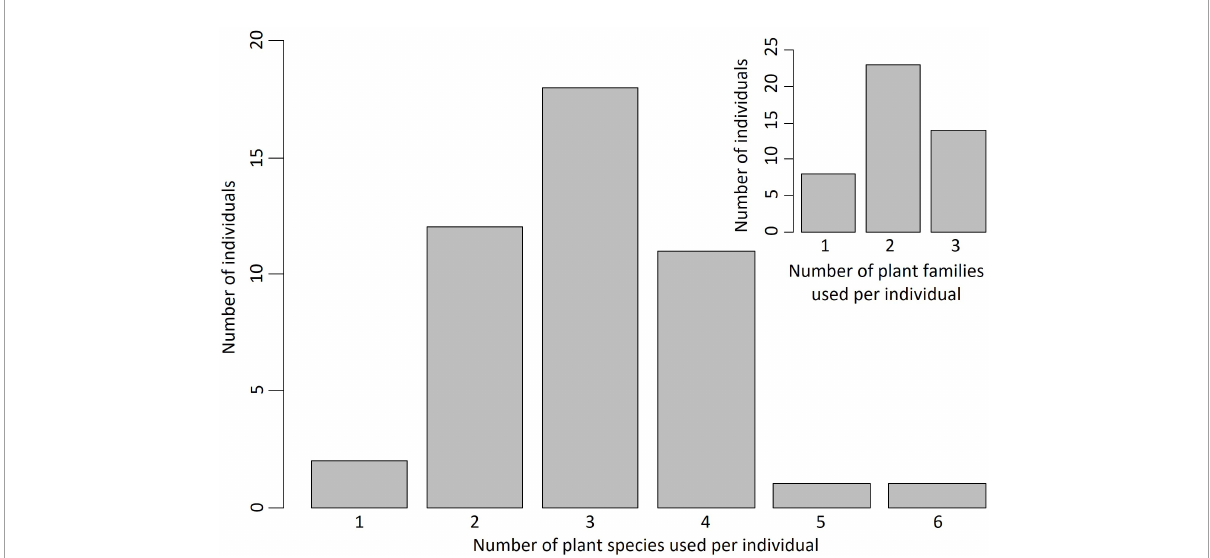
FIGURE1 Pollen beetles feed on plants from different species and families at the individual scale. Distribution of the number of species/families used per individual. n = 45.